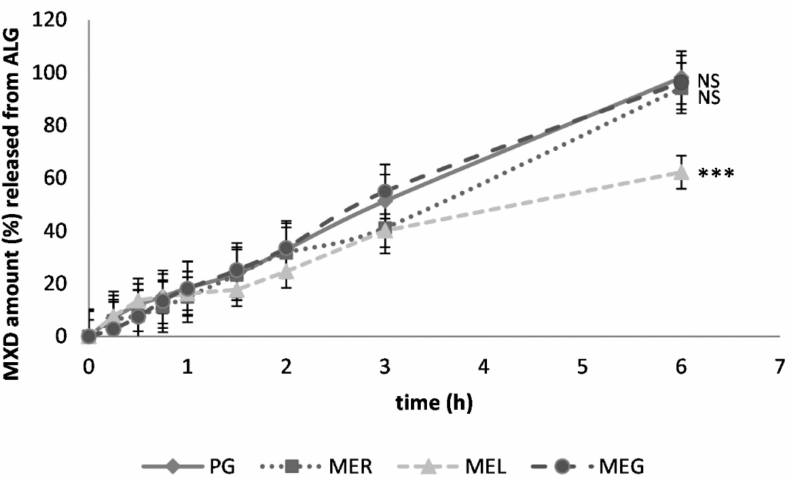
Figure 3. In vitro diffusion of MXD from sodium alginate gel (ALG) through semi-permeable membrane; previous solubilization in propylene glycol (PG), reference ME R , lecithin-containing ME L or gelatin-containing ME G . The cumulative MXD amount (%), a mean ± SEM, n = 4. Significantly different data against reference (PG) are at p < 0.005 (***), non-significantly different data (NS) are at p >